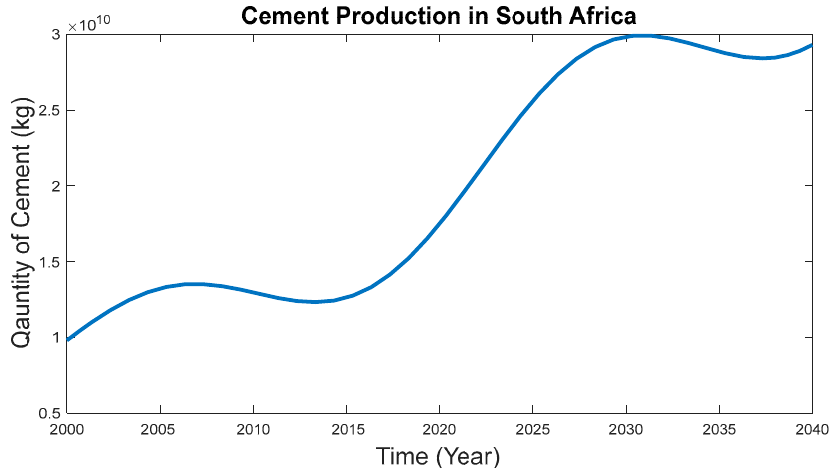
Figure 3. Plot showing a possible future dynamic of cement production in South Africa.